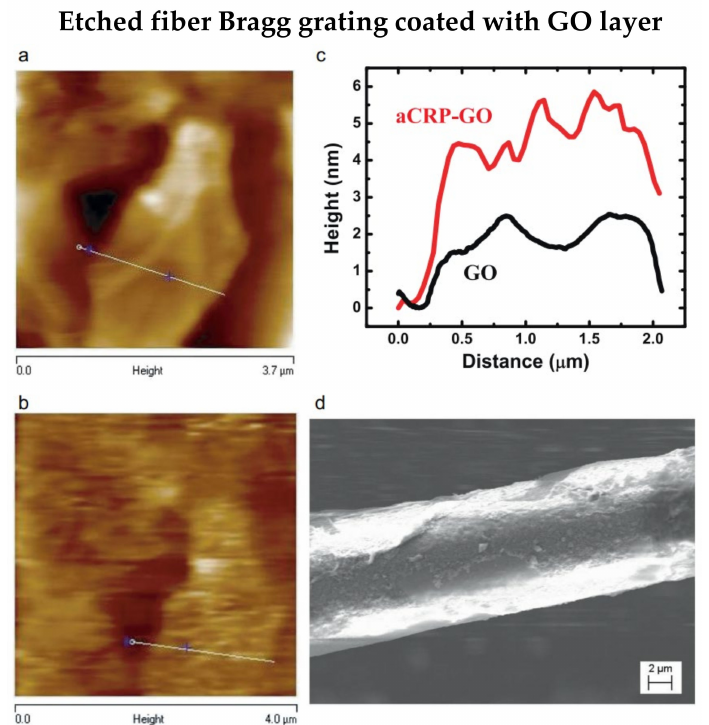
Figure 2. Atomic Force Microscopy image of pre ( a ) and post ( b ) functionalization of the etched FBG. ( c ) Height changes of GO layer, median height of 1.5 nm and 4.5 nm were observed pre and post functionalization of anti-CRP. ( d ) SEM image of functionalized optical fiber biosensor. Reprinted with permission from Ref. [36]. Copyright 2015,